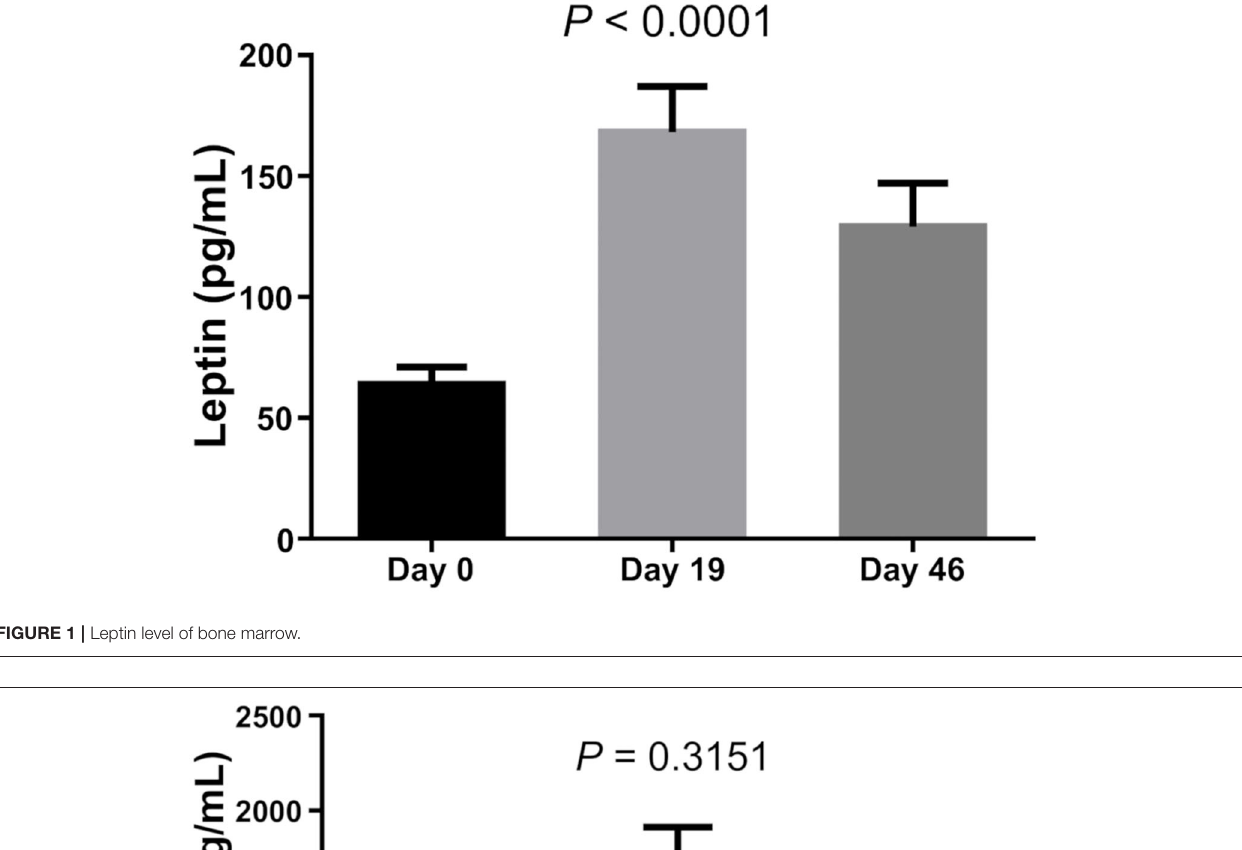
FIGURE 1 | Leptin level of bone marrow.